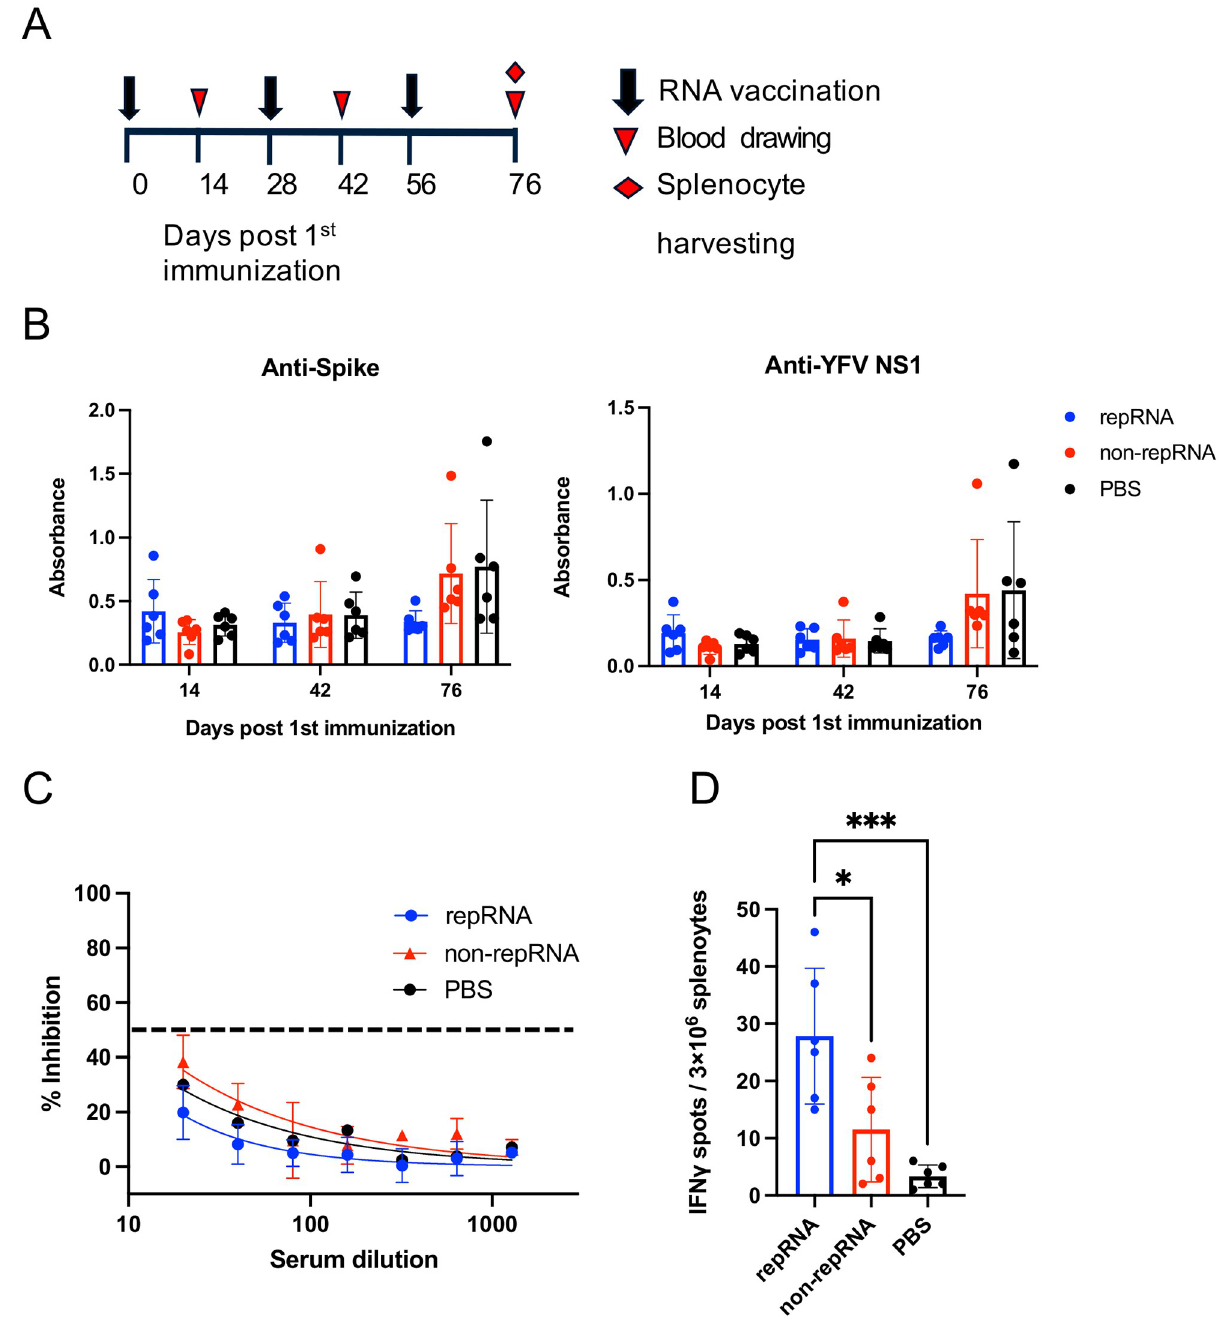
Fig 3. Evaluation of the repRNA and non-repRNA vaccines in vivo . (A) Immunization schedule for mice. Six-week-old C57BL/6 mice were immunized with 1- μ g repRNA vaccine, 1- μ g non-repRNA vaccine, or PBS (n = 6–7) via intratibial route with electroporation. Serum and/or splenocytes were harvested at 14, 42, and 76 days after the first immunization. (B) Measurement of anti-S IgG and anti-YFV NS1 antibody level. (C) Neutralizing activity in mouse sera. Neutralizing activity was measured using SARS-CoV-2 pseudovirus neutralization assay. Luminescence was measured at 48 h after pseudovirus infection. The dotted line indicates the 50% neutralization. (D) ELISpot assay using splenocytes. On day 76, splenocytes were harvested, and IFN- γ response was measured using ELISpot assay. p-values were determined using one-way ANOVA, with p < 0.05 considered to be significant ( � p < 0.05, ��� p < 0.001). Statistically significant values are represented in the graphic.